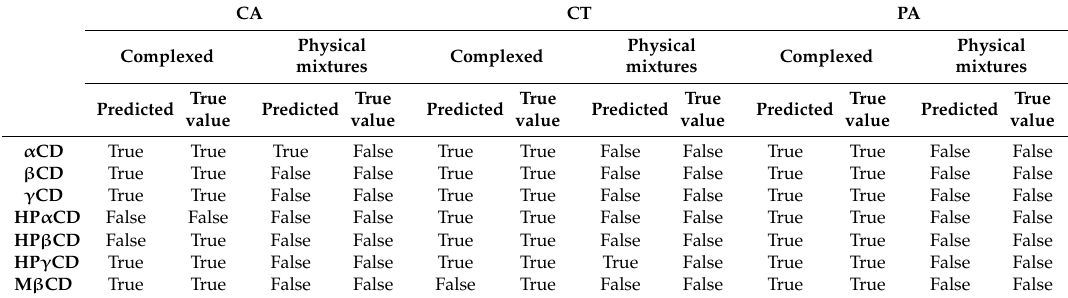
Testing predictions of the model, where True–complexed sample, False–physical mixture/noncomplexed